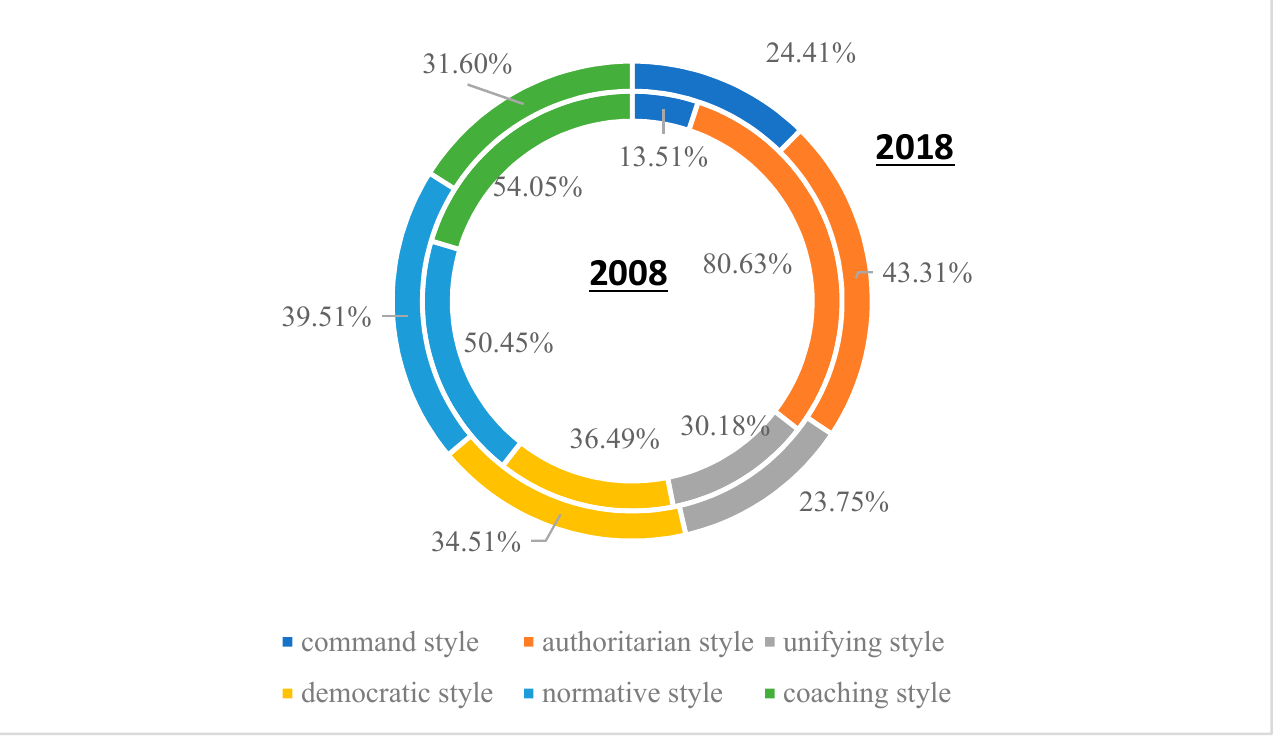
Figure 8. ( a ) Evaluation of the effectiveness of individual leadership styles (by D. Goleman) in the opinion of leaders of the Forbes Global 2000 world’s largest corporations—general context. ( b ) Evaluation of the effectiveness of individual leadership styles (by D. Goleman) in the opinion of leaders of the Forbes Global 2000 world’s largest corporations—corporate business context.